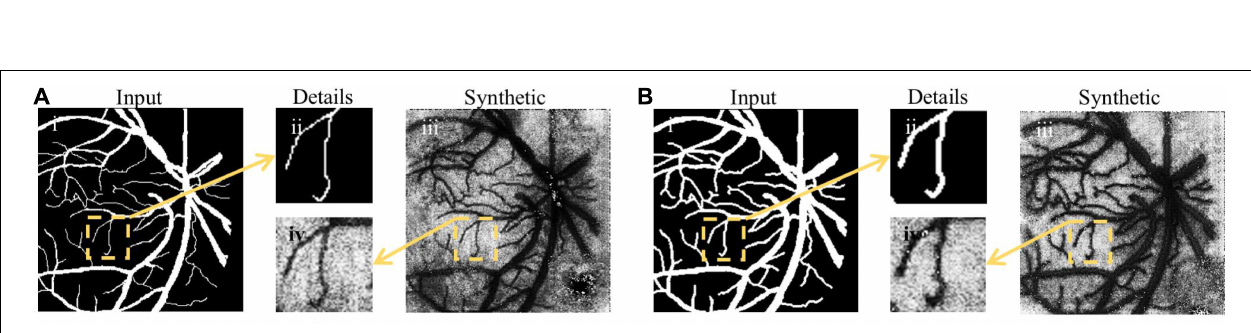
FIGURE 6 | Examples of image synthesis. (A) Image synthesis result without size-matching; (B) image synthesis result with vdSM. Columns (from left to right) indicate the input fundus image, the comparison of small vessel details, and the synthetic laser speckle contrast image, respectively.